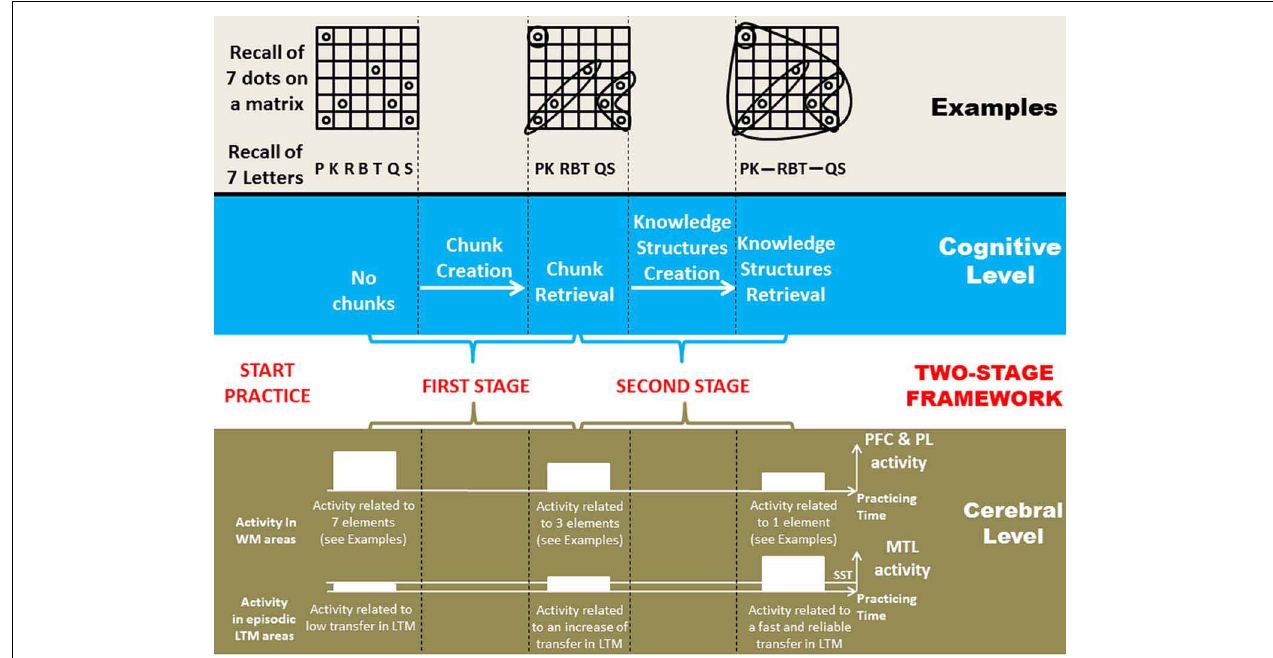
FIGURE 1 | Schematic representation of the Two-Stage Framework linking the cognitive and cerebral levels in expertise acquisition, through two examples. The “Examples” section shows the evolution of the effect of knowledge on how items to-be-remembered are processed: at first, items are processed almost separately, later, items are regrouped in chunks, and finally in knowledge structures, which can be viewed as super-chunks that regroup multiple chunks into a high-level pattern. In the “Cerebral Level” section, the representation of brain activity is at an ordinal scale. SST stands for statistical significance threshold; if brain activity is beneath this threshold, it goes undetected. PFC stands for